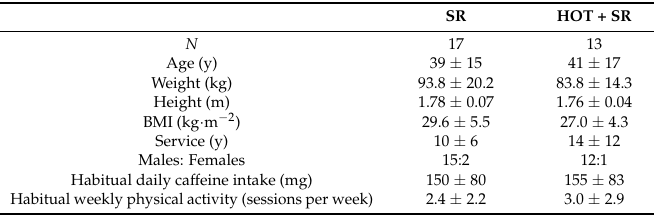
Table 1. Ethical approval was obtained from the Deakin University Human Research Ethics Committee (DUHREC 2014-040) and the Human Research Ethics Committee of Central Queensland University